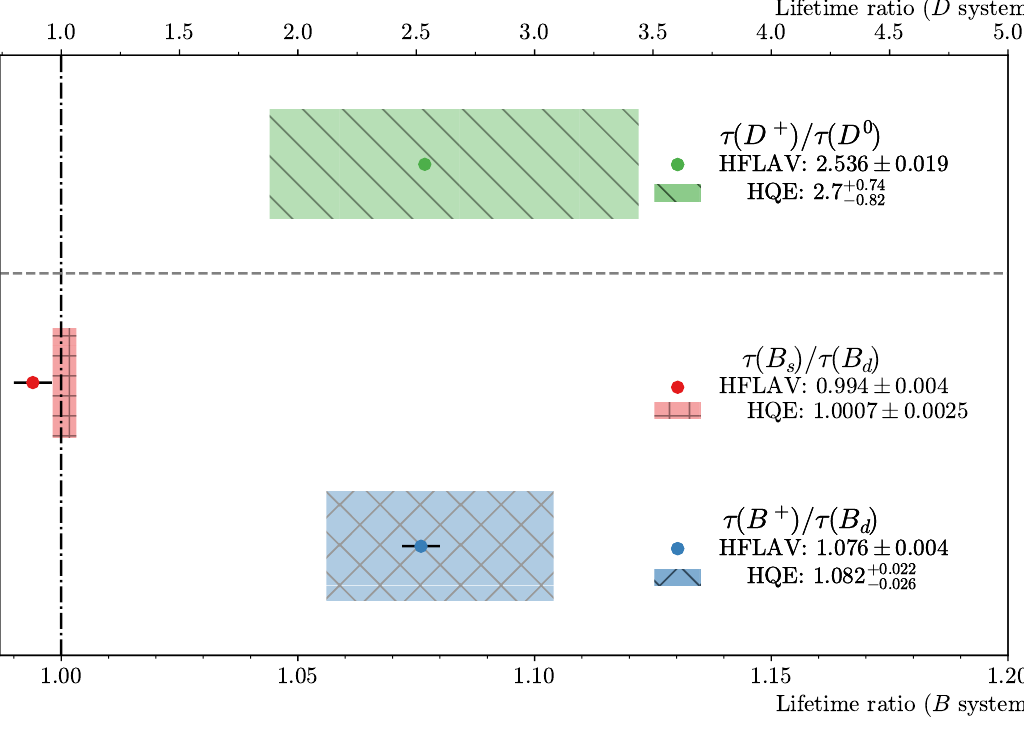
Figure 9 . Comparison of our predictions for the lifetime ratios of heavy mesons with the present experimental